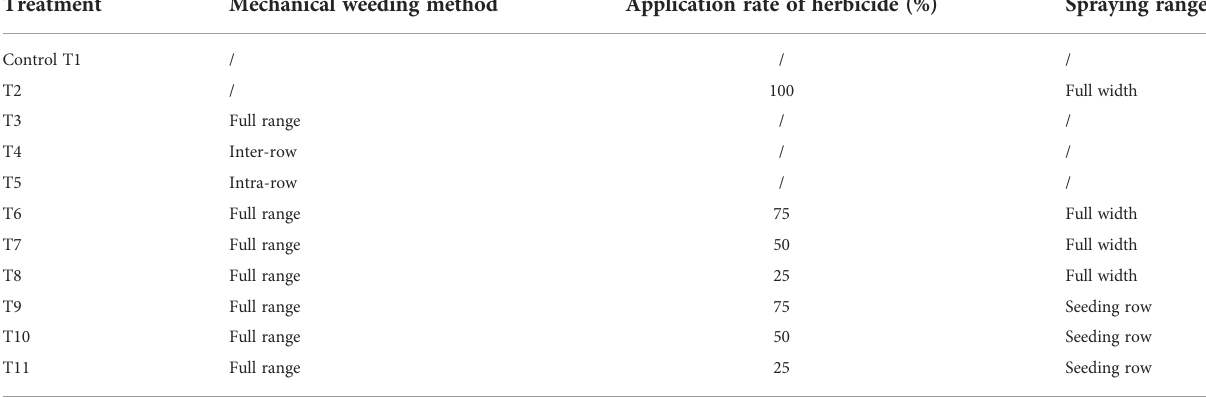
TABLE 1 Experimental